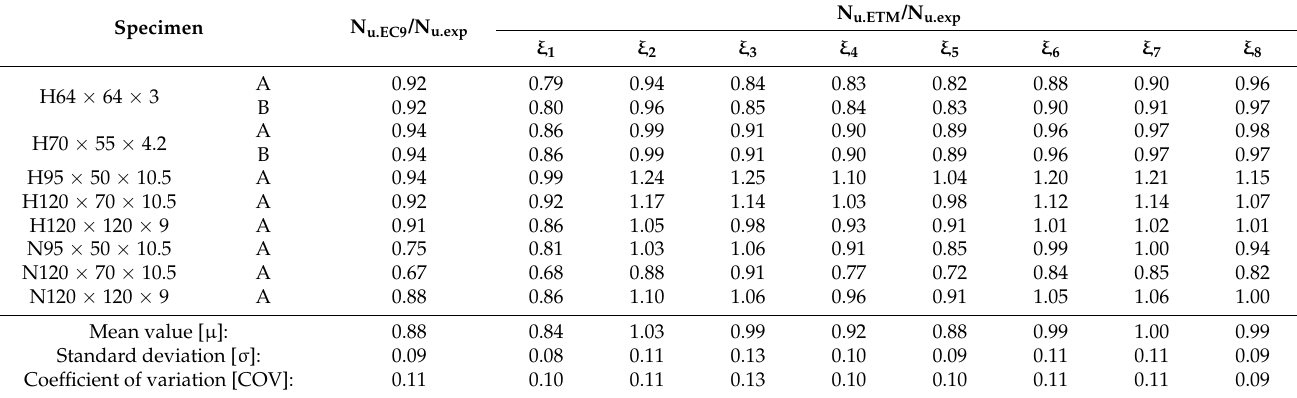
Table A4. Ratio values between the theoretical and experimental results in the case of uniform compression.